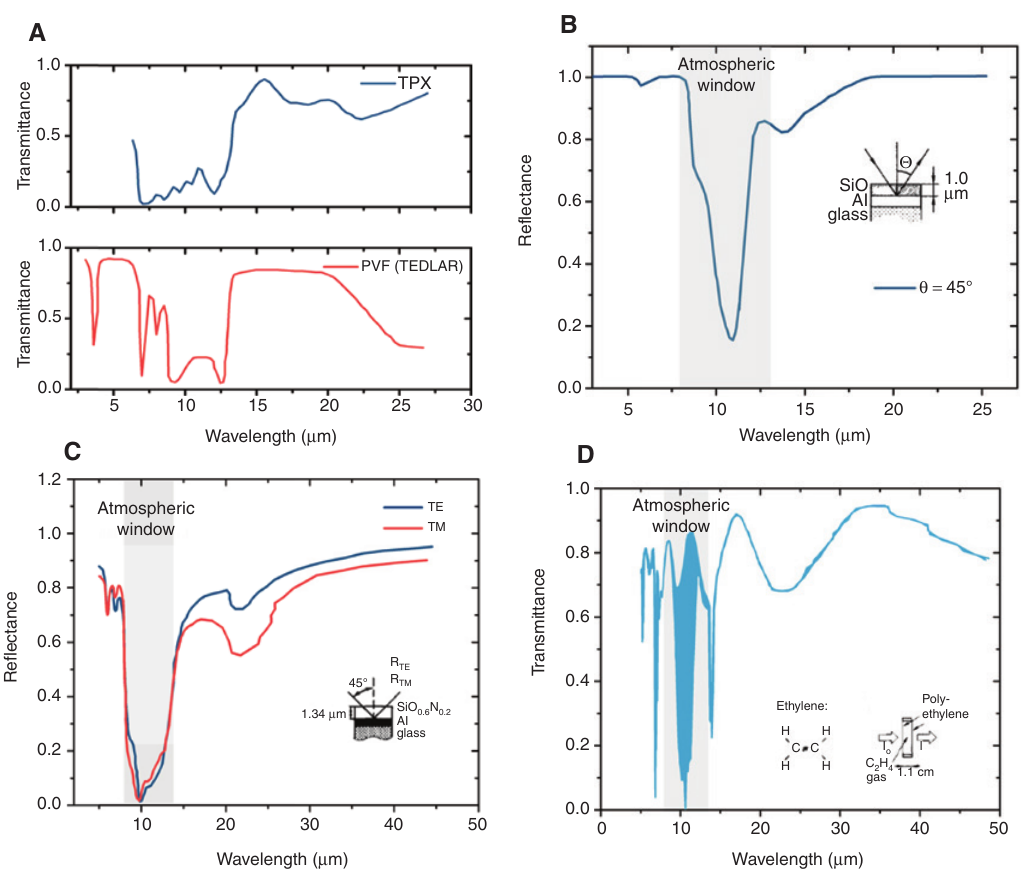
Figure 4: (A) Transmittance spectrum of aluminized polyvinyl fluoride (TEDLAR) cooler (red) and polymethylpentene (TPX) cooler (blue); adapted from [2, 52]. Strong emittance can be observed within the atmospheric window. (B) the measured reflectance spectrum of 10 μ m SiO film on aluminum (Al). The spectrum is adapted from [2]. (C) The measured reflectance for TM (red) and TE (blue) polarizations incident on a 1.34 μ m SiO N film on Al. Compared to SiO, a broader peak is found within the atmospheric window. The 0.6 0.2 spectrum is adapted from [56]. (D) The measured transmittance spectrum of ethylene gas in a 1.1-cm-thick gas slab. The spectrum is adapted from